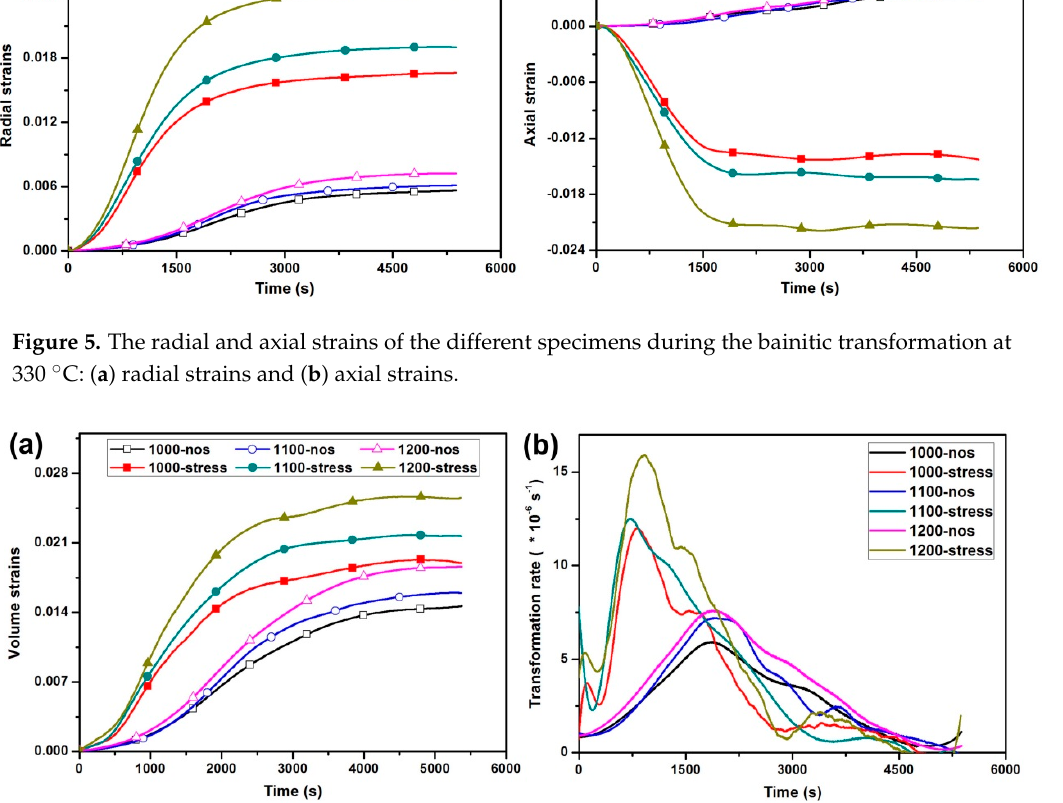
Figure 5. The radial and axial strains of the different specimens during the bainitic transformation at 330 °C: ( a ) radial strains and ( b ) axial strains.